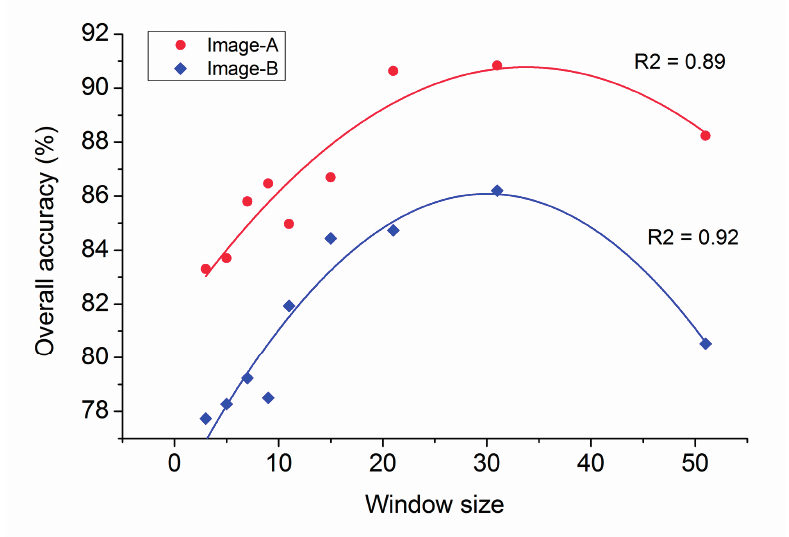
Figure 9. Fitted curve describing how OA changes with window sizes for Image-A and